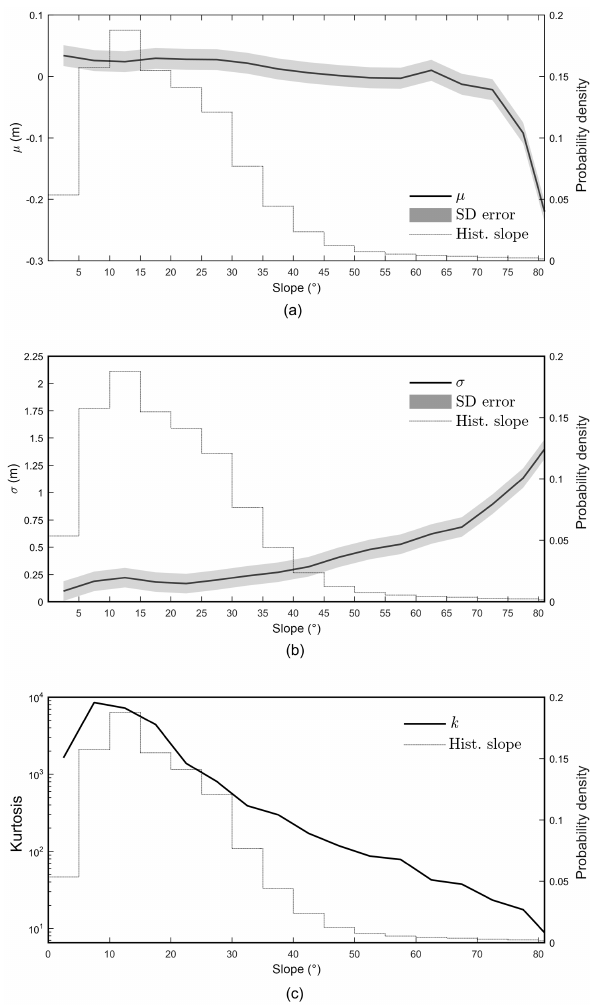
Figure 7. Comparison of histograms and accompanying descrip- tive statistics for the residual between DSMs for slopes between 5 and 10 ◦ and slopes between 70 and 75 ◦ . Flatter slopes are found to exhibit extreme kurtosis relative to steeper slopes. Normal and t location-scale ( t ) distributions are